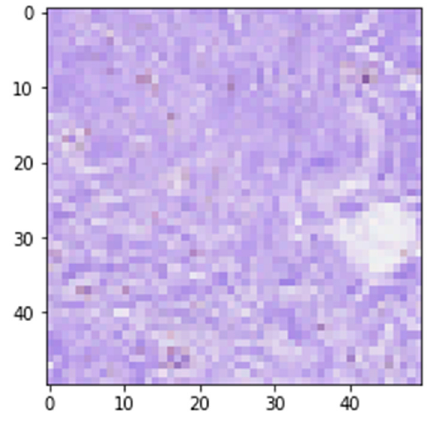
Figure 6. Preprocessed extracted patches from the data samples.